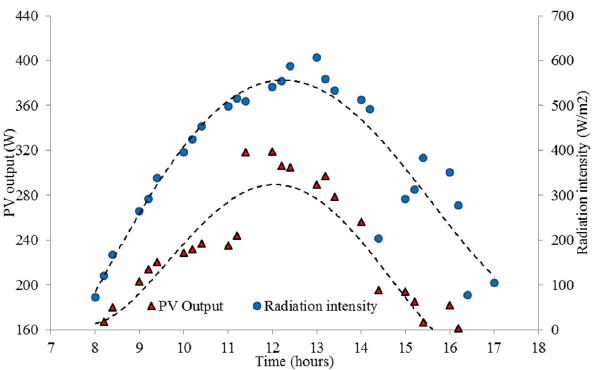
Figure 3. Variation of measured solar irradiance and photovoltaic (PV) panel output over a day.